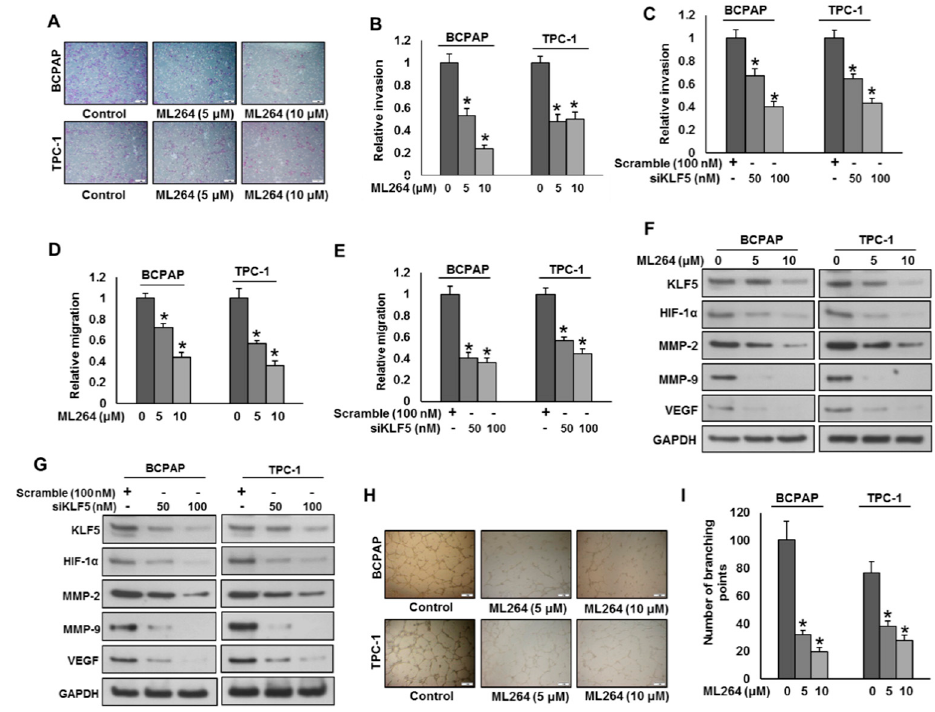
Figure 3. Downregulation of KLF5 inhibits tumor cell invasion, migration and angiogenesis. ( A , B ) KLF5 inhibition decreases the invasive capacity of PTC cells. PTC cells were treated with indicated doses ML264 and seeded into the upper compartment of invasion chambers. The bottom chambers were filled with RPMI media. After 24 h incubation, invaded cells were fixed, stained and quantified. ( C ) Silencing of KLF5 decreases invasion of PTC cells. PTC cells were transfected with scrambled siRNA and KLF5 siRNA (50 and 100 nM). After 48 h, cells were seeded into the upper compartment of invasion chambers. The bottom chambers were filled with RPMI media. After 24 h incubation, invaded cells were fixed, stained and quantified. ( D ) KLF5 inhibition causes reduction in the migration capacity of PTC cells. PTC cells were treated with indicated doses ML264 and seeded into the upper compartment of migration chambers. The bottom chambers were filled with RPMI media. After 24 h incubation, migrated cells were fixed, stained and quantified. ( E ) Silencing of KLF5 decreases migration of PTC cells. PTC cells were transfected with scrambled siRNA and KLF5 siRNA (50 and 100 nM). After 48 h, cells were seeded into the upper compartment of migration chambers. The bottom chambers were filled with RPMI media. After 24 h incubation, migrated cells were fixed, stained and quantified. ( F ) ML264 treatment down-regulates the expression of MMP-2, MMP-9 and VEGF in PTC cells. PTC cells were treated with indicated doses of ML264 for 48 h. After cell lysis, equal amounts of proteins were separated by SDS-PAGE, transferred to immobilon membrane, and immuno-blotted with antibodies against KLF5, HIF-1 α , MMP-2, MMP-9, VEGF and GAPDH, as indicated. ( G ) Silencing of KLF5 down-regulates the expression of MMP-2, MMP-9 and VEGF in PTC cells. PTC cells were transfected with scrambled siRNA and KLF5 siRNA (50 and 100 nM). After 48 h, cells were lysed and proteins were immunoblotted with antibodies against KLF5, HIF-1 α , MMP-2, MMP-9, VEGF and GAPDH. ( H , I ) KLF5 inhibition decreases HUVECs tube formation. HUVECs grown on matrigel were treated with conditioned media from KLF5 treated and untreated PTCs for 24 h, cells were fixed, and tubular structures were photographed and quantified. Data presented in the bar graphs are the mean ± SD of triplicates in an independent experiment which was repeated for at least two times with the same results. * Indicates a statistically significant difference compared to control with p < 0.05. Western blot experiments were repeated at least two times with the same